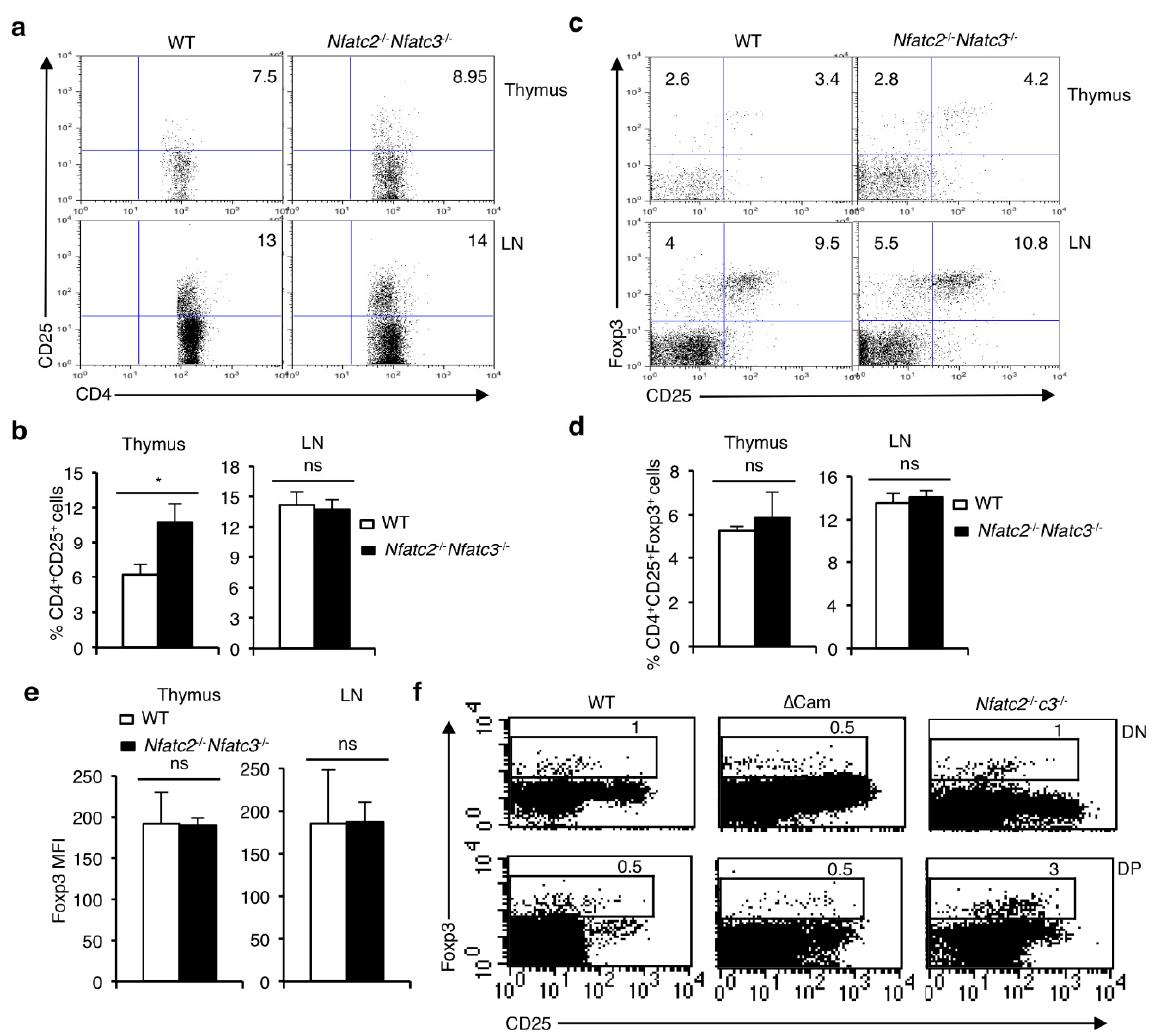
Figure 2. Development of Foxp3 + T reg cells is unaffected in Nfatc2 -/- Nfatc3 -/- mice. ( a ) Distribution of CD4 + CD25 + T cells among CD4 + T cell population in the thymus and LN of Nfatc2 -/- Nfatc3 -/- mice compared to WT littermates. ( b ) Quantification of percent CD4 + CD25 + T cells among CD4 + T cell population in the thymus and LN of Nfatc2 -/- Nfatc3 -/- mice compared to WT controls ( n = 3 each, * p = 0.0120, ns = not significant; unpaired t -test). ( c ) Distribution of CD4 + CD25 + Foxp3 + T reg cells in the thymus and LN of Nfatc2 -/- Nfatc3 -/- and WT mice gated on CD4 + T-cells. ( d ) Quantification of the frequency of CD4 + CD25 + Foxp3 + T reg cells in the thymus and LNs from WT and Nfatc2 -/- Nfatc3 -/- mice ( n = 5 WT and 3 Nfatc2 -/- Nfatc3 -/- mice; ns = not significant; unpaired t -test). ( e ) Quantification of MFI for Foxp3 in thymic and LN Foxp3 + cells from WT and Nfatc2 -/- Nfatc3 -/- mice (ns = not significant; unpaired t -test). ( f ) Distribution of Foxp3 + cells in DN and DP thymocyte populations from WT, ∆ Cam and Nfatc2 -/- Nfatc3 -/- mice. Data are representative of two independent experiments, and in ( b , d , e ) are presented as mean ± s.d.